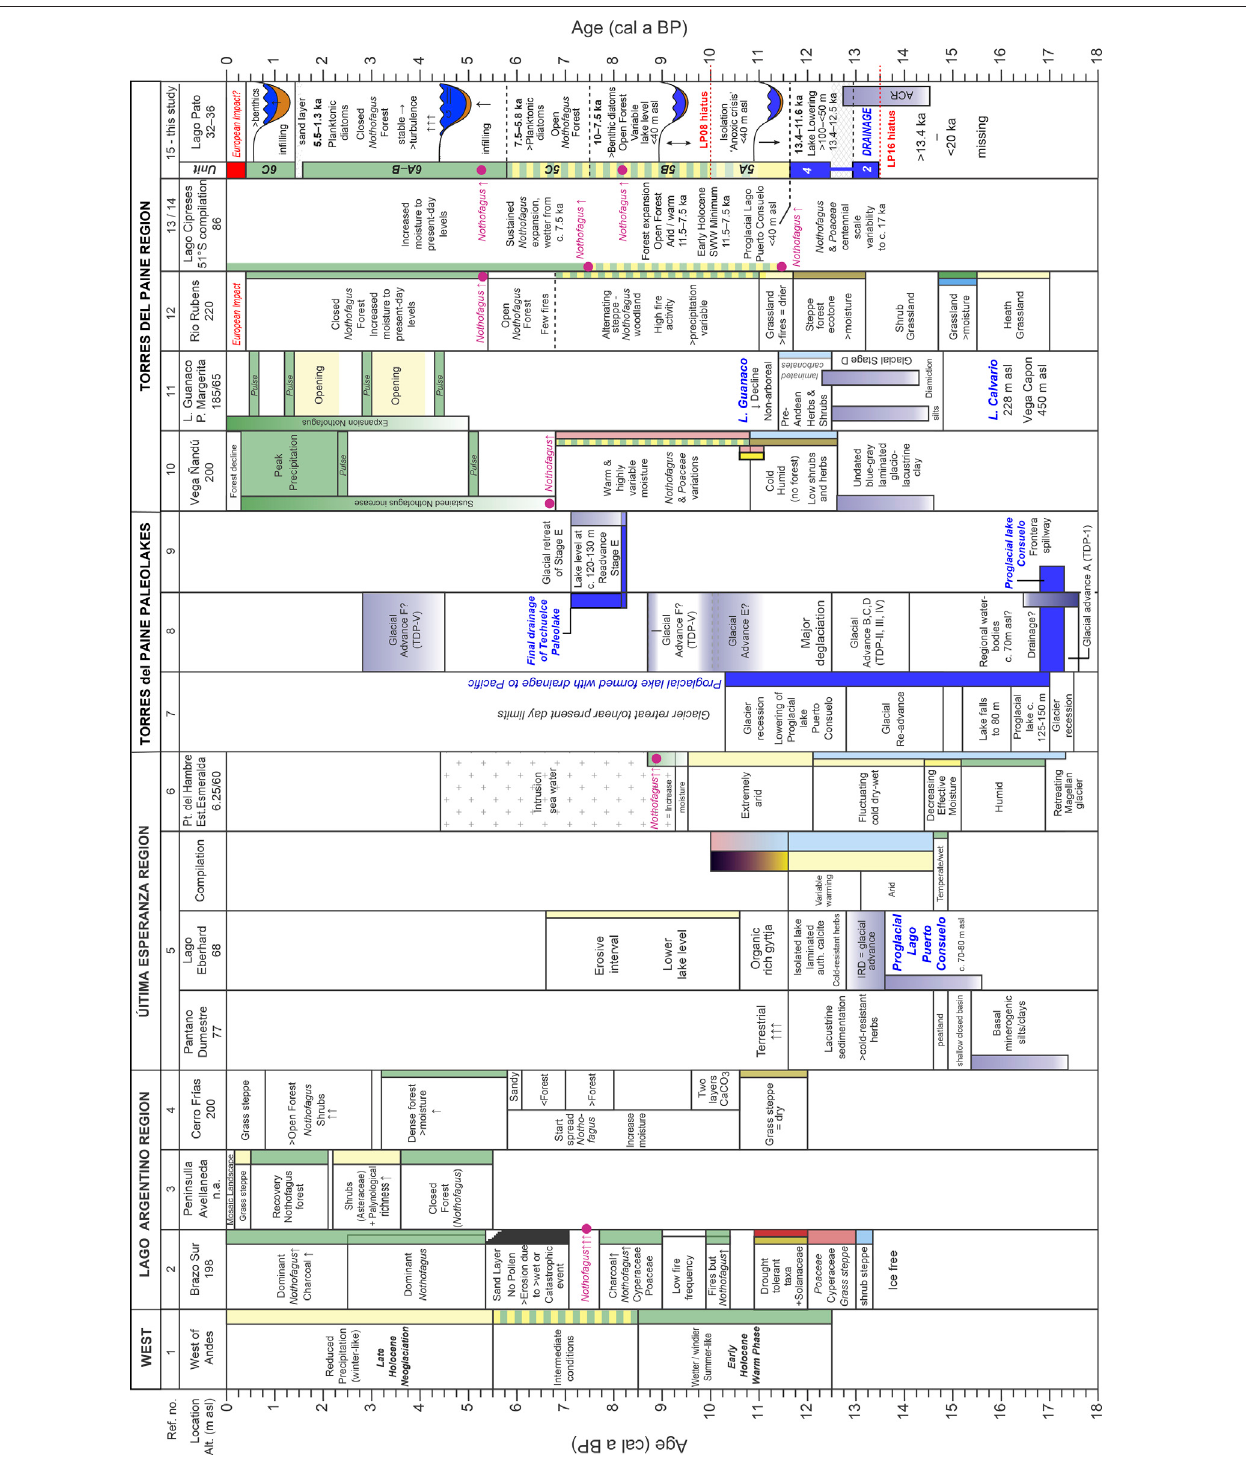
FIGURE 3 | Summary palaeoenvironmental interpretations for key studies from in Chilean Patagonia mentioned in the text (1 – 14). Summary fi ndings from Lago Pato from this study are included in 15 for comparison. References: 1, Lamy et al. (2010); 2, Wille and Schäbitz (2008); 3, Echeverria et al. (2014); 4, Mancini (2009); 5, Moreno et al. (2012); 6, McCulloch and Davies (2001); 7, Sagredo et al. (2011); 8, García et al. (2014); 9, Solari et al. (2012); 10, Villa-Martínez and Moreno (2017); 11, Moreno et al. (2009a) and Moreno et al. (2009b); 12, Markgraf and Huber (2010); 13/14, Moreno et al. (2018) and Moreno et al. (2021); 15, this study.